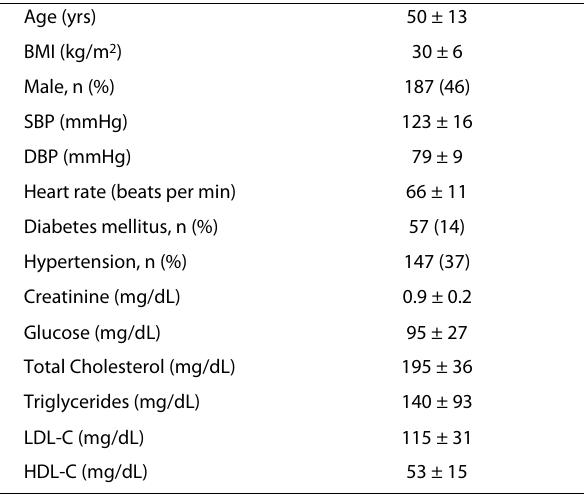
Table 1: Clinical characteristics of study subjects (n =